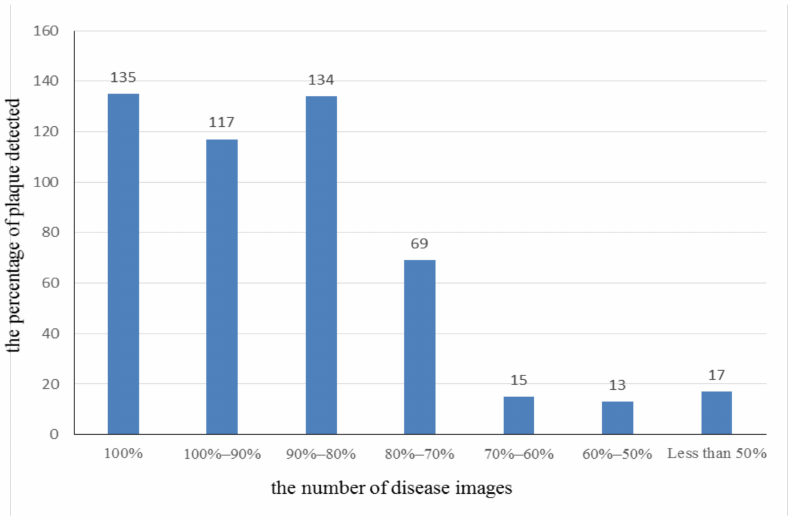
Figure 11. The statistics of disease area detection.